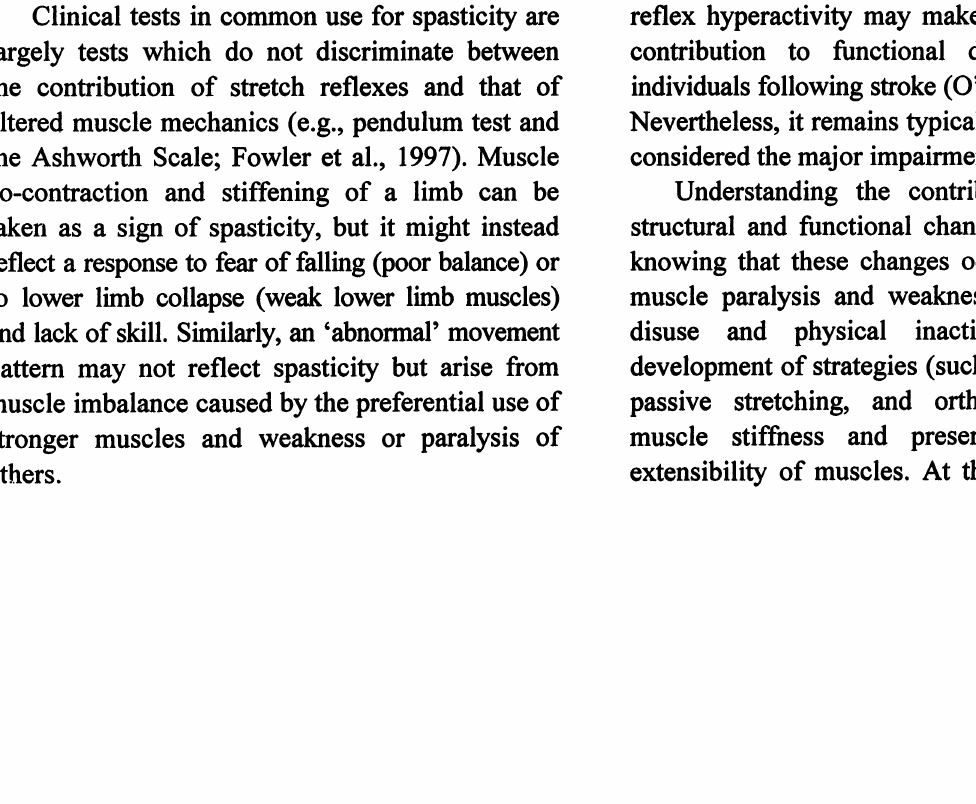
muscle and connective tissue (increased stiffness and other length and disuse-associated changes), with the contribution of hyperreflexia remaining